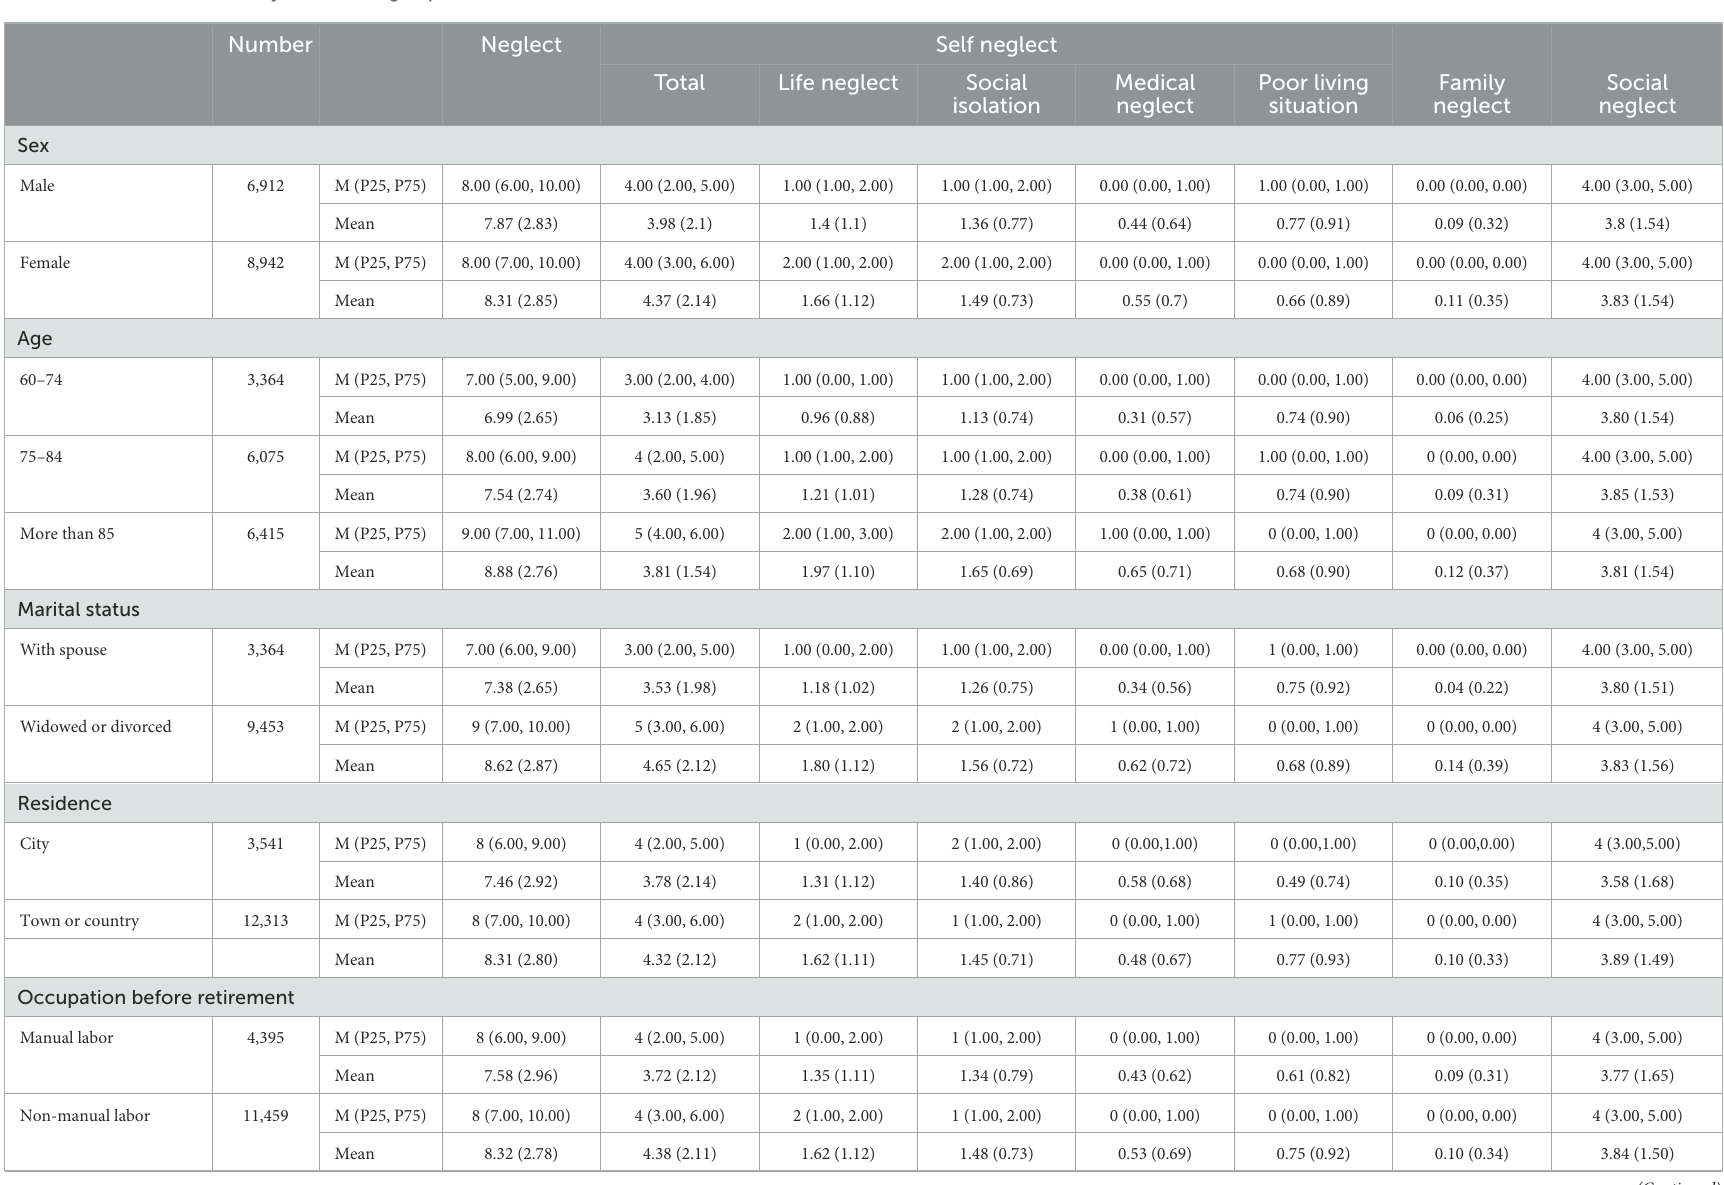
TABLE 2 Score in each domain by different subgroup of EN.